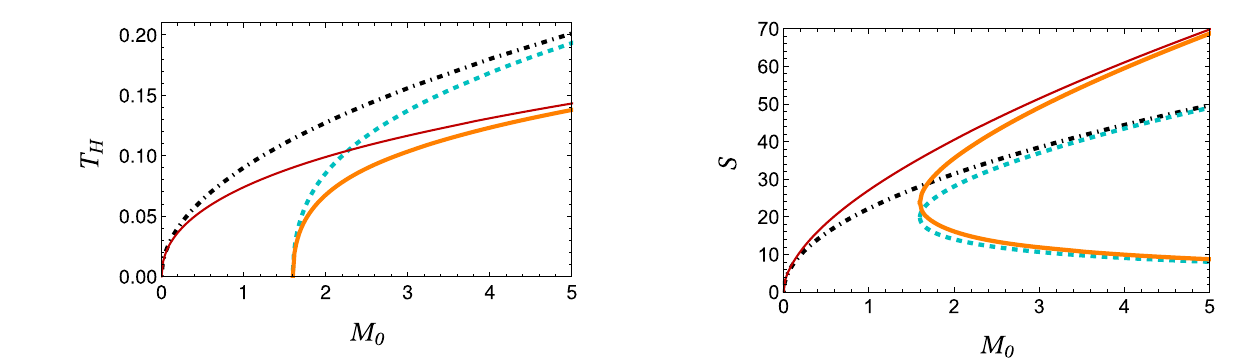
Fig. 5 The Bekenstein-Hawking entropy S as function of classical mass M 0 for four different cases: (cid:12) = 0 and J 0 = 0 (dotted dashed black line), (cid:12) = 0 and J 0 = 8 (blue dashed line), (cid:12) = 0 . 1 and J 0 = 0 (solid thin red line) and (cid:12) = 0 . 1 and J 0 = 8 (solid thick orange line). In addition (cid:8) 0 = 5 and the values of the rest of the parameters have been taken as